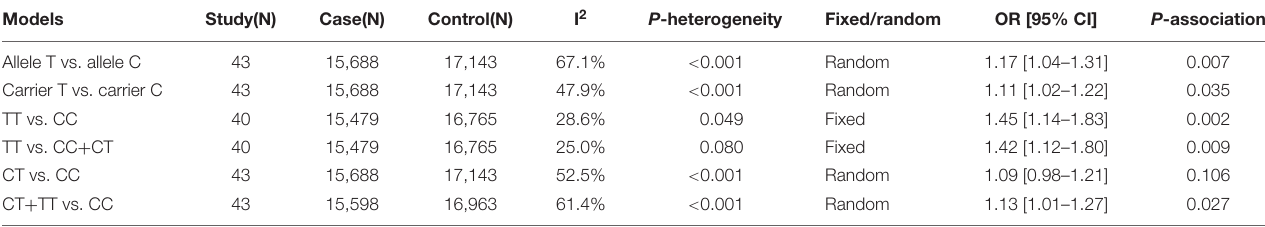
TABLE 2 | Meta-analysis of the overall population.